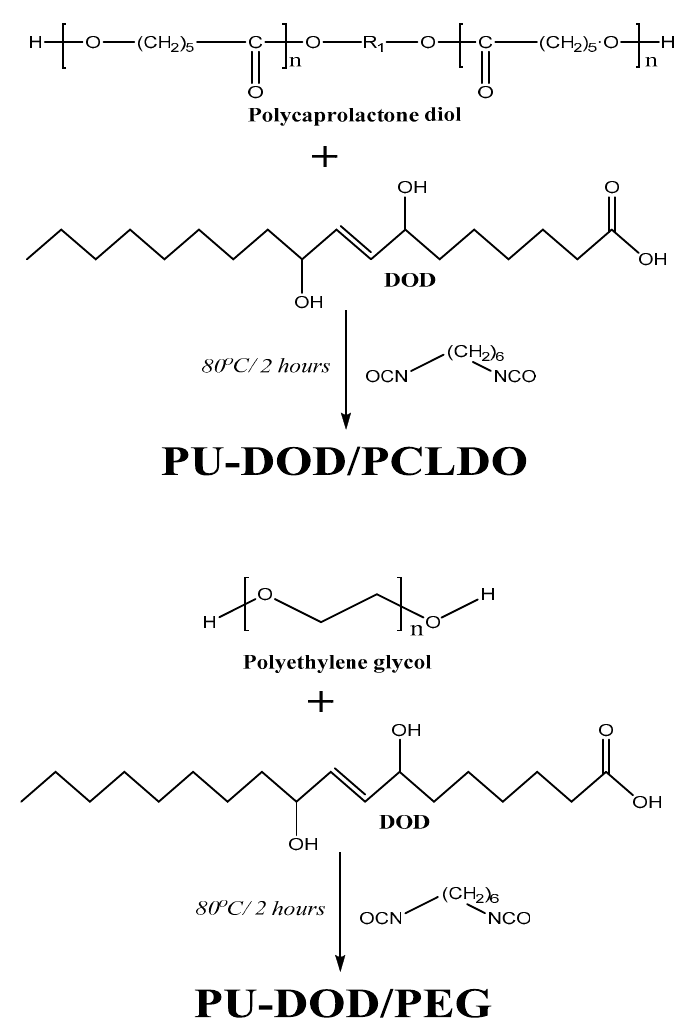
Figure 7. Reaction schemes for the synthesis of PU-DOD/ polycaprolactone diol (PCLDO) and PU-DOD/ polyethylene glycol (PEG).